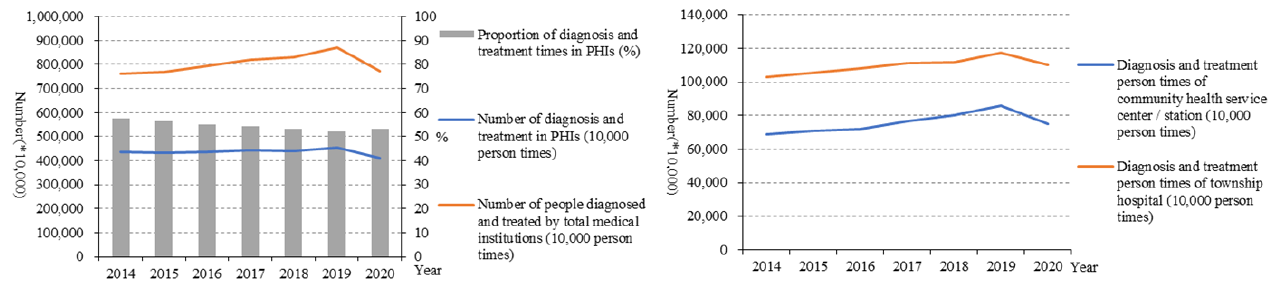
Figure 6. Number of diagnoses and treatments in PHIs (10,000 person ‐ times).